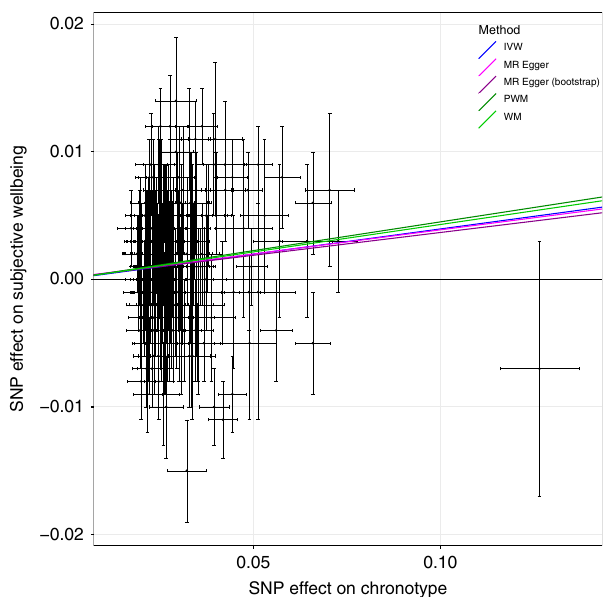
Fig. 6 MR scatter plot of subjective well-being outcome vs. chronotype exposure. Plot showing chronotype meta-analysis variants and their effects (log odds ratios) on subjective well-being in the SSGAC GWAS 79 (outcome) versus odds of being a morning person (exposure). Lines identify the slopes of the fi ve methods tested. Log odds (and SEs) for morningness were taken from the secondary effect-size meta-analysis. Error bars represent standard errors of effect